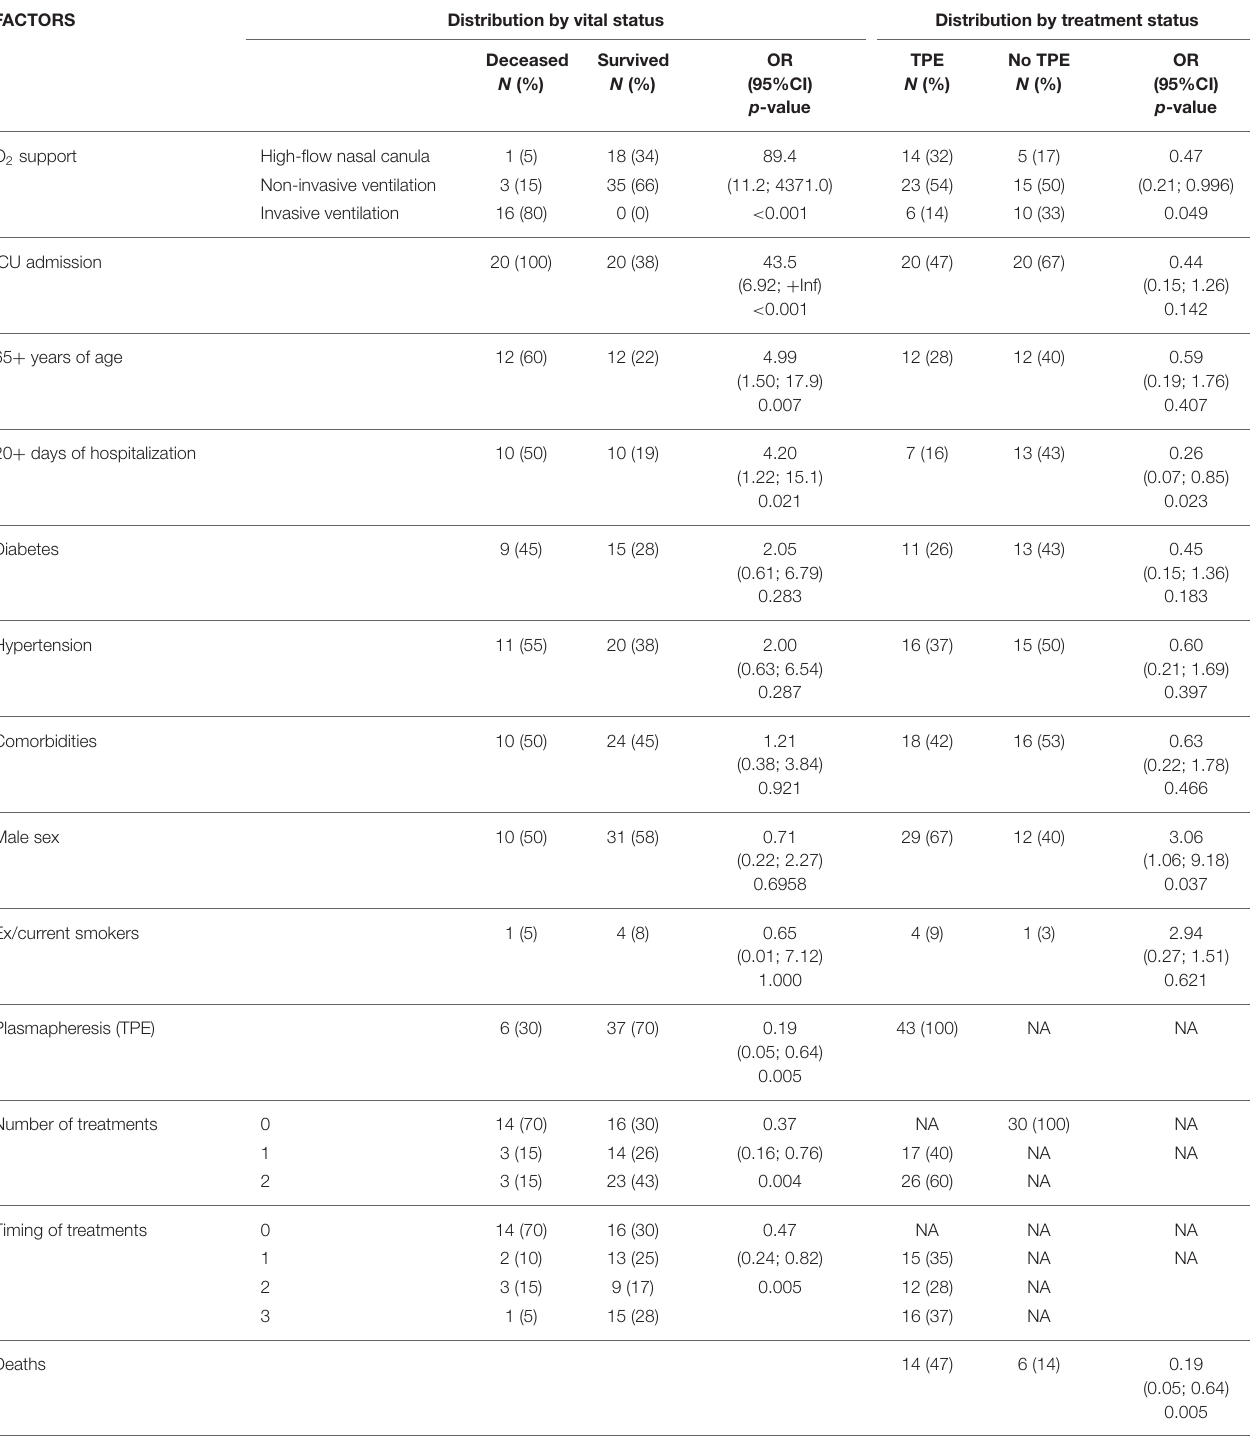
TABLE 1 | Distribution of 73 patients with COVID-19 by vital and treatment status: number ( N ) and percentage (%) of cases; exact odds ratio (OR); 95% confidence interval (95%CI) and two-tail p -values.